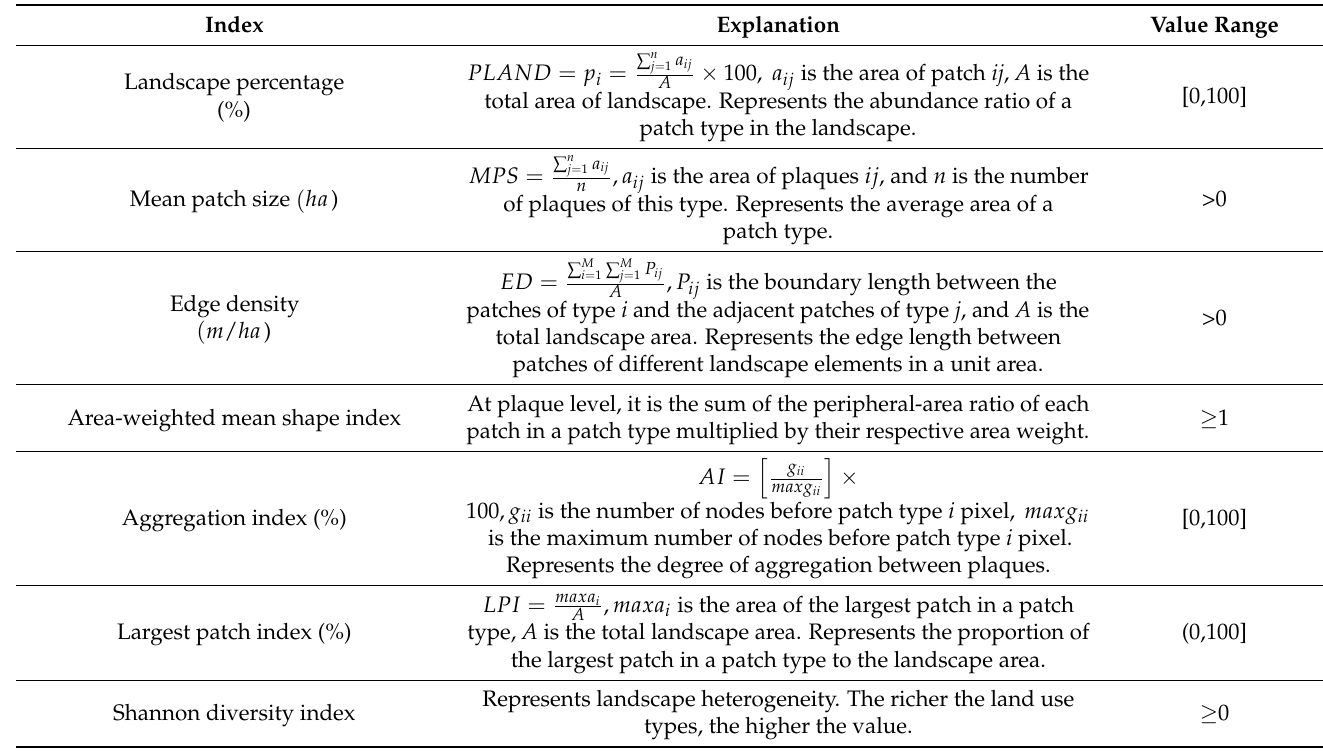
Table 2. Description of the selected landscape pattern indices